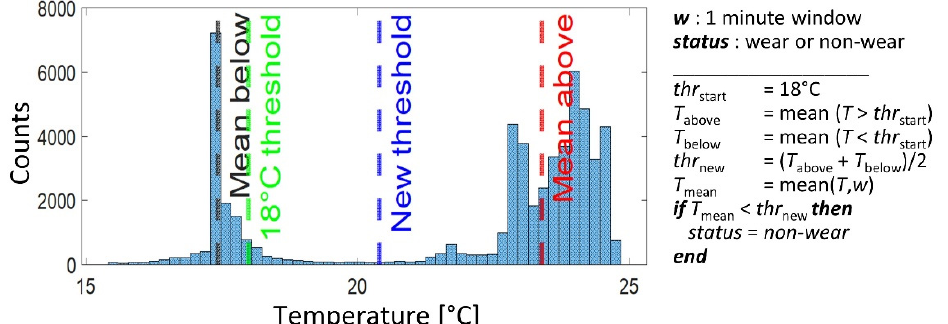
Figure 2. Illustrative example of the temperature (T) distribution of data recorded from one partici- pant and pseudocode for dynamic threshold (thr) computation.